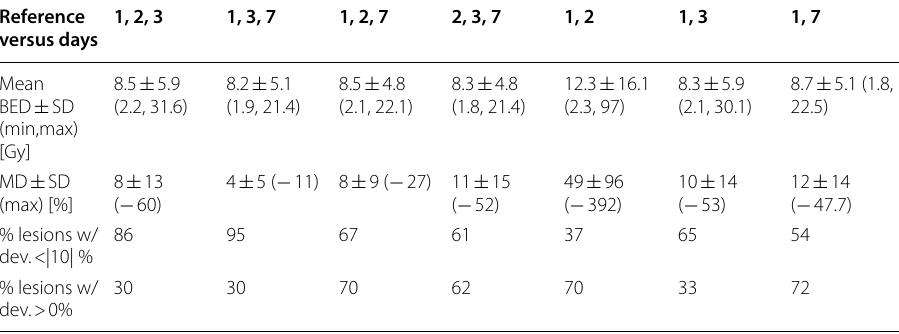
Table 3 Mean lesion BEDs and deviations from the reference model f percentage of lesions with less than |10| % deviation and only positive deviation from the reference are reported. The latter evaluates how many lesions are overestimated. The mean BED max) of the reference model is 8.2 5.0 Gy (2.0 Gy, 21.7 ±